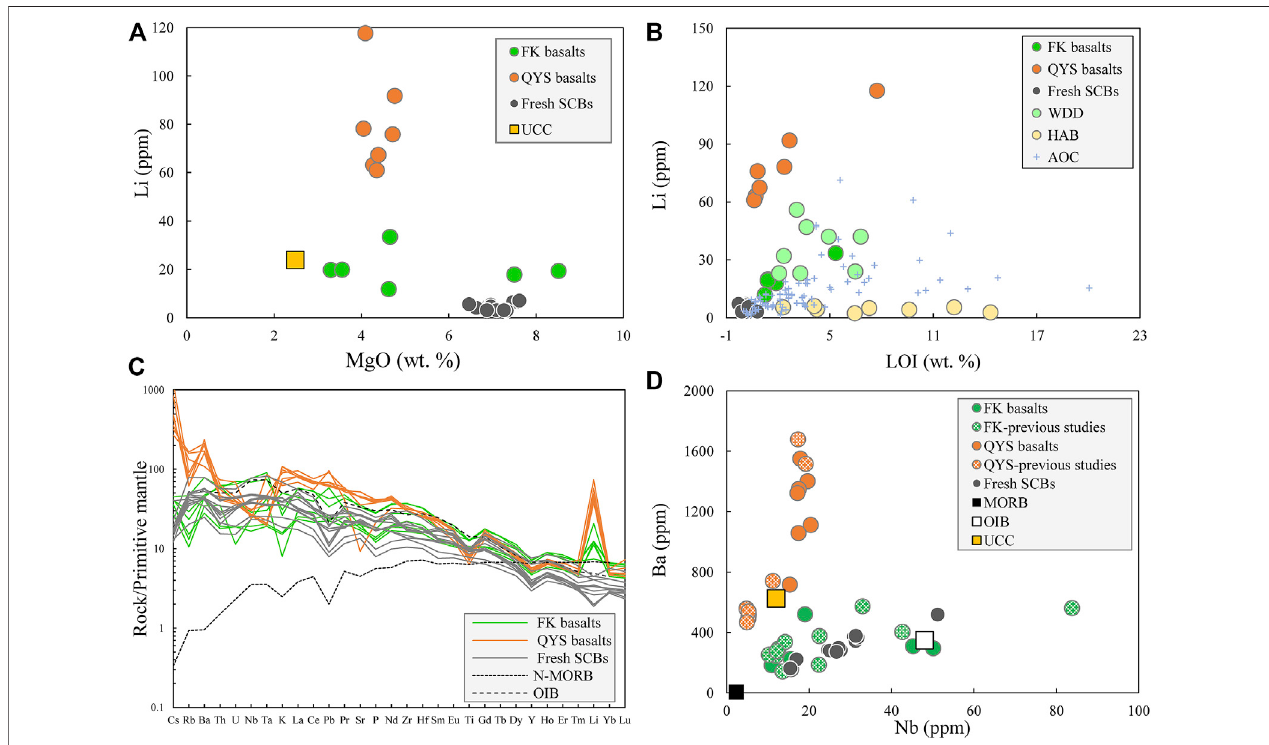
FIGURE 2 | Geochemical plots of fresh and altered South China basalts (SCBs) showing (A) MgO vs. Li and (B) LOI vs. Li. The weathered diabase dykes from SouthCarolina(WDD)belowa6 mboundaryandhydrothermallyalteredbasalts(HABs)fromHengillinSWIcelandarefromtheworkofRudnicketal.(2004)andVerney- Carronetal.(2015),anddataofthealteredoceaniccrust(AOC)arecompiledin SupplementaryTableS3 . (C) Primitivemantlenormalizedtraceelementpatternforthe fresh and altered SCBs. The data of primitive mantle are from the work of McDonough and Sun (1995), and MORB/OIB data are from the work of Sun and McDonough (1989). (D) Nb vs. Ba. The previous dataset for Fankeng (FK) basalts is from the work of Zhou et al. (2005) and Chen et al. (2008), and Qingyunshan (QYS) basalts are from the work of Chen et al. (2008) and Meng et al. (2012). The upper continental crust (UCC) is from the work of Rudnick and Gao